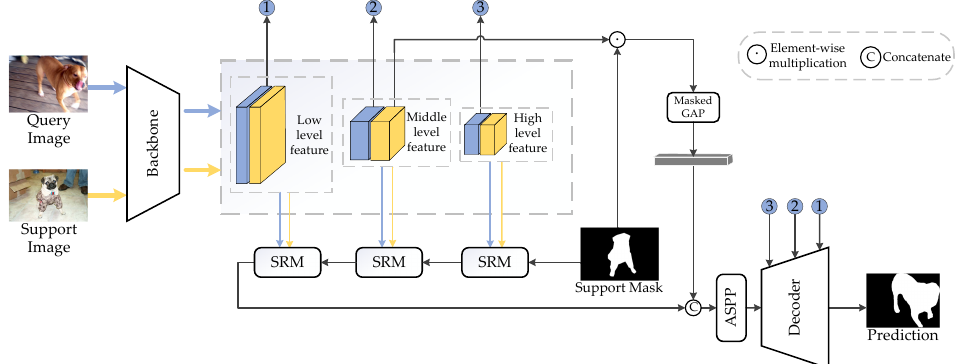
Figure 1. The framework of our multilevel features-guided network. The query image and the support image are fed into the backbone (shared weights) to obtain three-level features (inside the larger dotted box), blue/yellow parts represent query/support features. There are three similarity- guided feature reinforcement modules (SRM) that sequentially process three-level query/support feature pairs. The three-level query features (small blue circles) are cross-connected to the decoder part for segmentation guidance. GAP and ASPP are abbreviations for Global Average Pooling and Atrous Spatial Pyramid Pooling